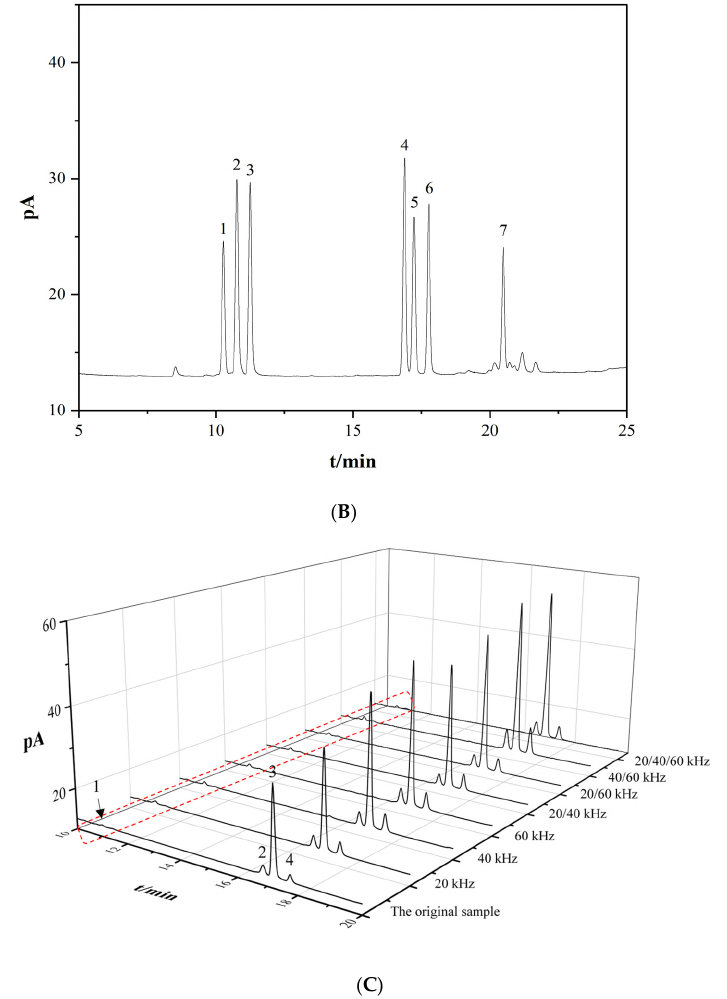
Figure 1. UV spectrum of lentinan ( A ); gas chromatogram of a standard monosaccharide saccharin acetate derivative: (1) rhamnose, (2) arabinose, (3) xylose, (4) mannose, (5) glucose, (6) galactose, (7) inose (interior label) ( B ); monosaccharide composition of lentinan ( C ).